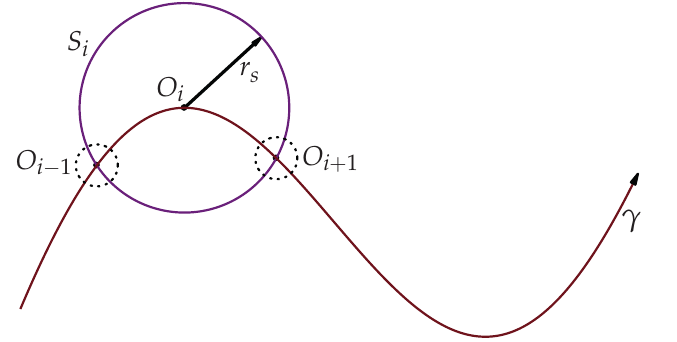
Figure 3. Representation of a hypersphere on the homotopic curve γ .